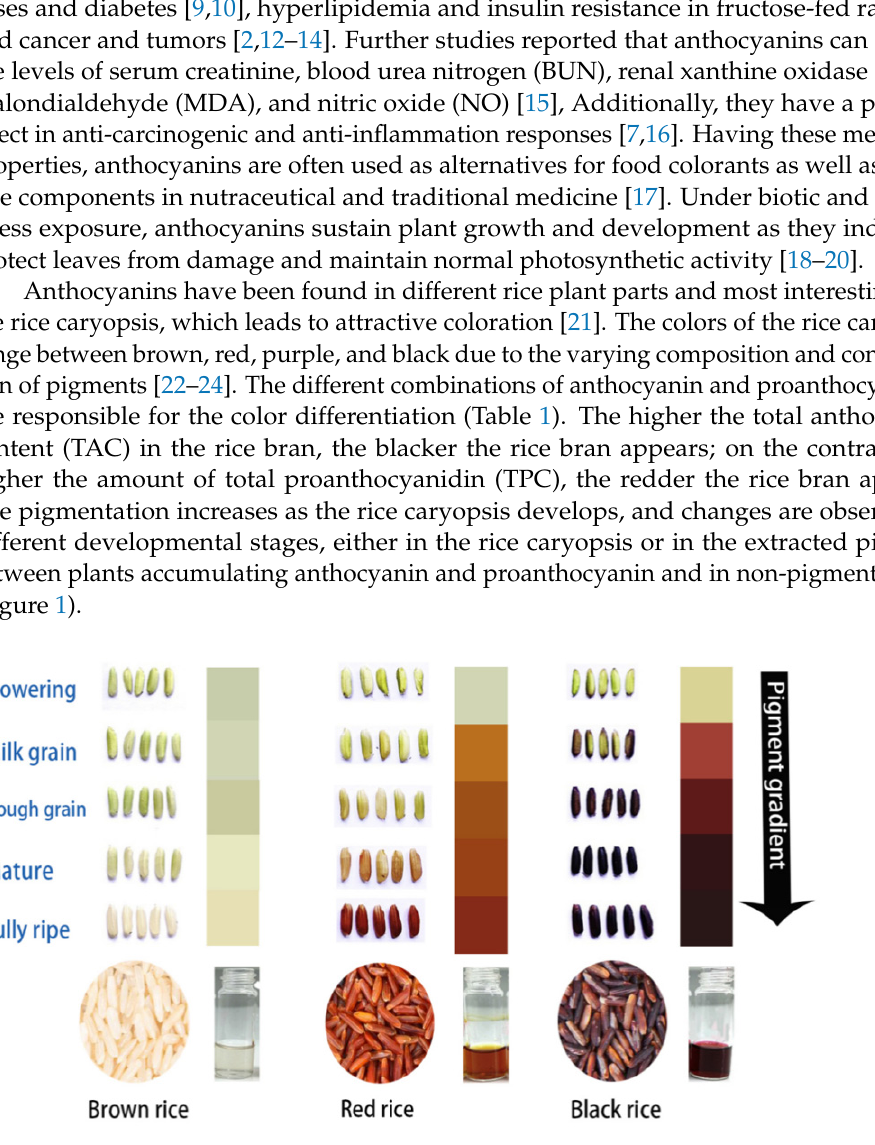
Figure 1. The pigment gradient in black rice compared to brown and red rice caryopses during developmental stages. Note: This figure was drawn and adapted based on the experiment conducted by Jiamyangyuen et al., 2017.